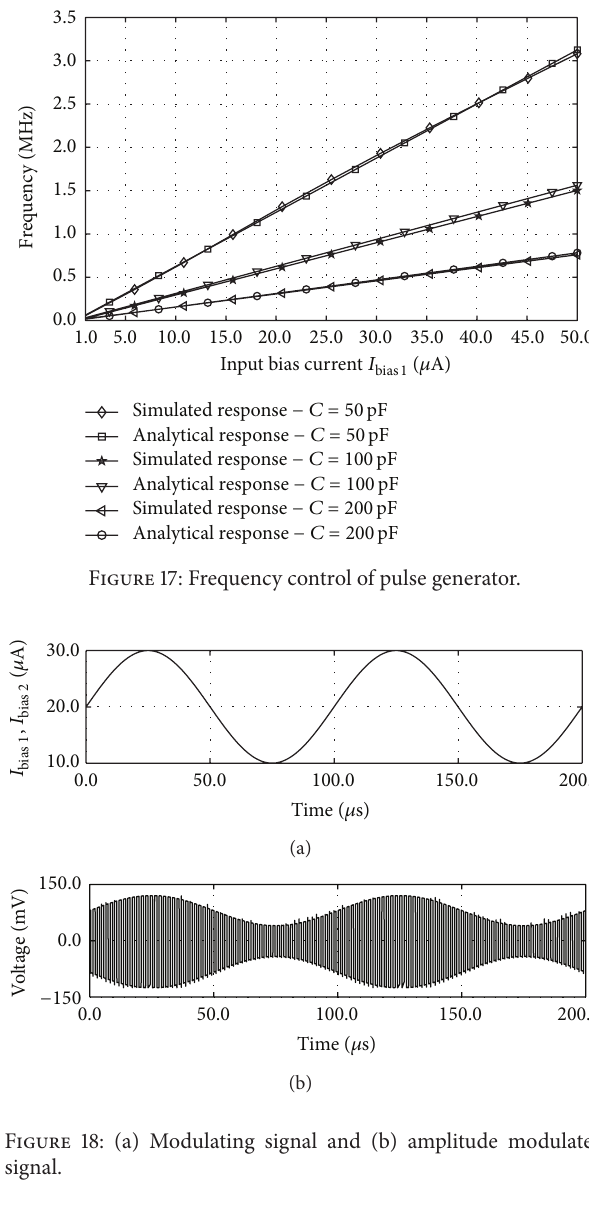
Figure 18: (a) Modulating signal and (b) amplitude modulated signal.